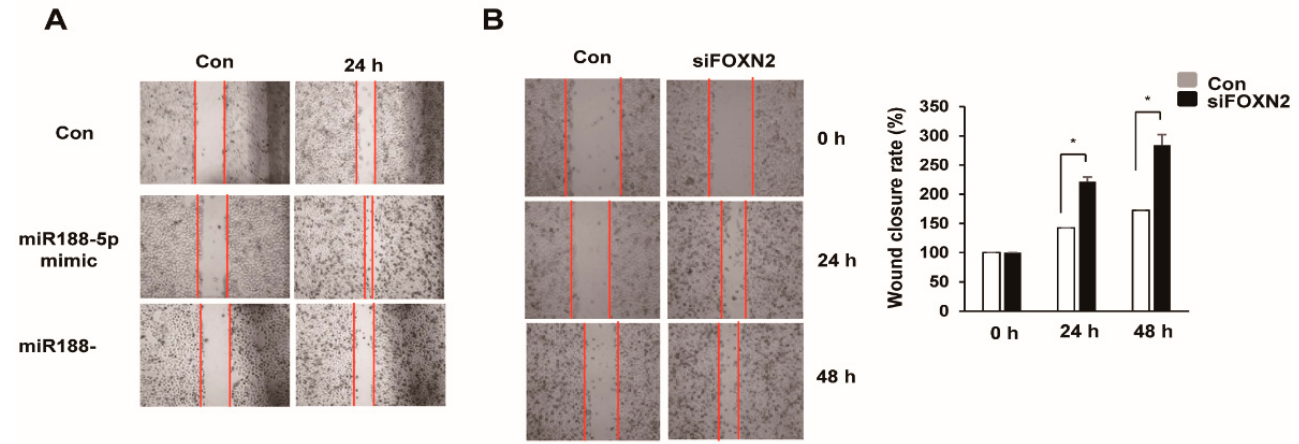
Figure 6. miR-188-5p regulates cell migration in FaDu cells. ( A ) Cell migration in FaDu cells transfected with miR-188-5p mimics and inhibitor was evaluated via wound healing assays. ( B ) Effect of FOXN2 in inhibiting cell migration. FaDu cells transfected with siFOXN2 for 24 h or 48 h. A monolayer of confluent FaDu cells was wounded with a sterile pipette tip. Wound closure was observed by phase-contrast microscopy and photographed at 0, 24 h, and 48 h. The graph presents the wound closure rate (%). The data are shown as the mean ± SD of at least three independent experiments. * p < 0.05.